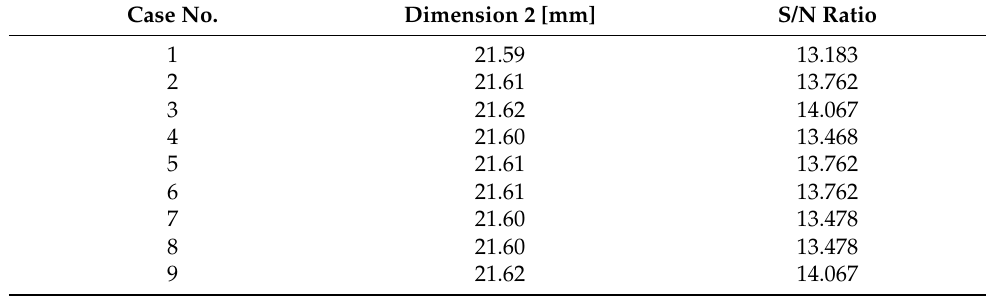
Table 18. S/N ratio of measurement 2 for open lever. Case No.